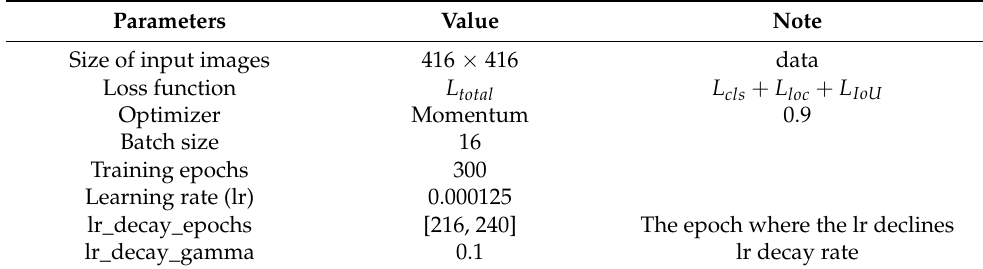
Table 3. Initialization parameters of our method.